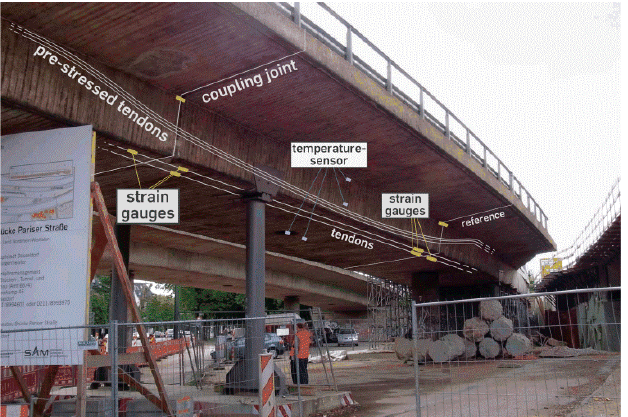
Figure 3. Strain and temperature monitoring of the reference structure.